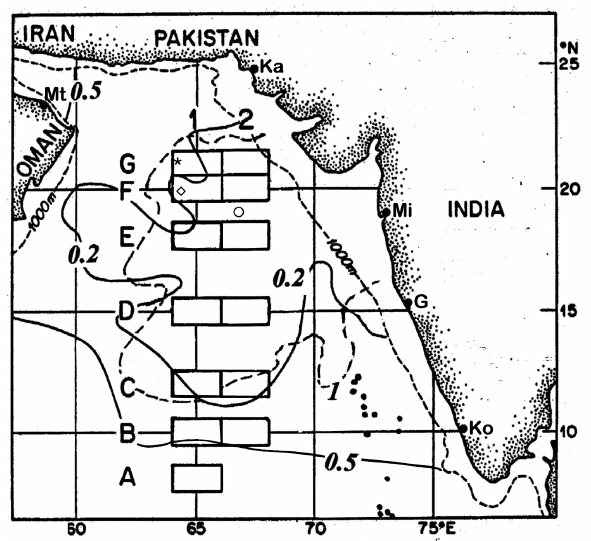
Fig. 1. Distribution of the boxes (left series, “1”, right series, “2”) with outlines of O 2 concentration (mLL − 1 ) at 200m (from Wyrtki, 1971) and the nitrite maximum (circumscribed by the 1µM contour) in the OMZ (from Naqvi, 1991). Circle: position of drift station shown in Fig. 2; diamond: position of GEOSECS sta. 416; aster- isk: position of drift station depicted in Supplement Fig. S.3.1; G: Goa; Ka: Karachi; Ko: Kochi (former Cochin); Mi: Mumbai (for- mer Bombay); Mt: